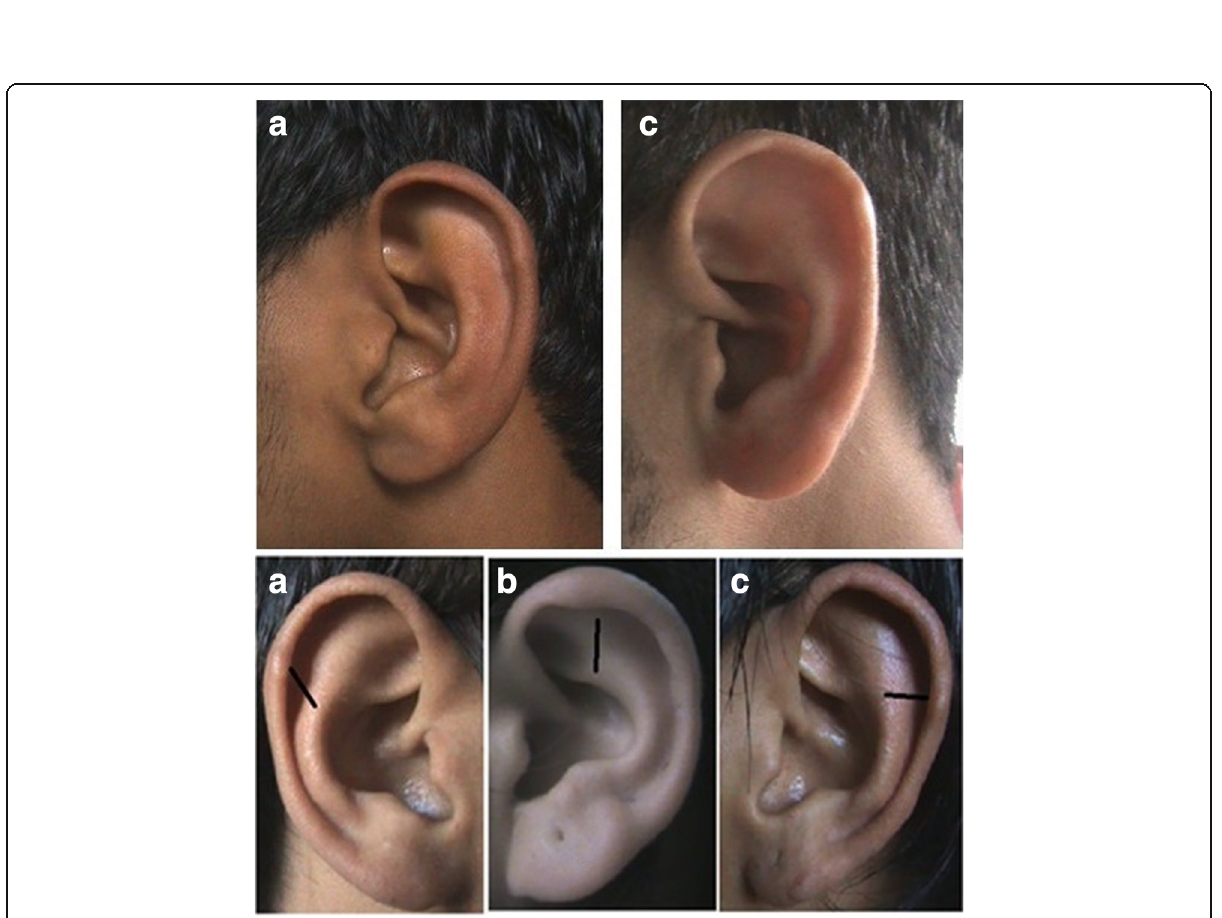
Fig. 8 Photographs showing the different forms of Darwin ’ s tubercles. a Nodosity. b Enlargement. c